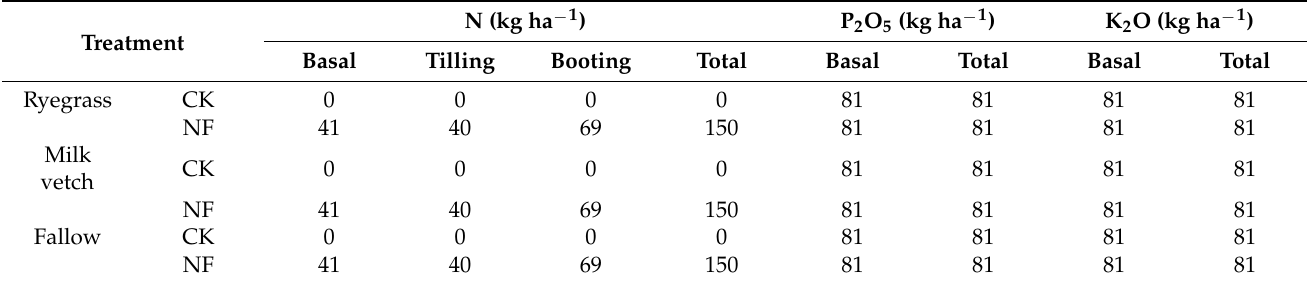
Table 1. Fertilizer application